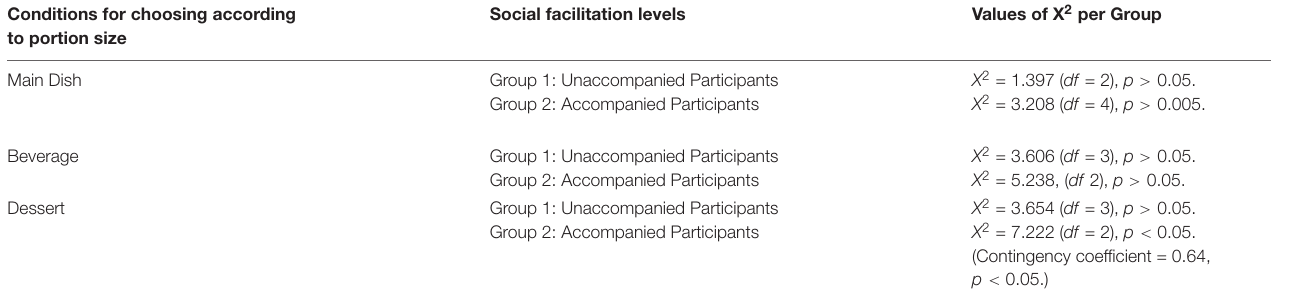
TABLE 3 | Chi-square results of main course, beverage, and dessert selection in session 3.